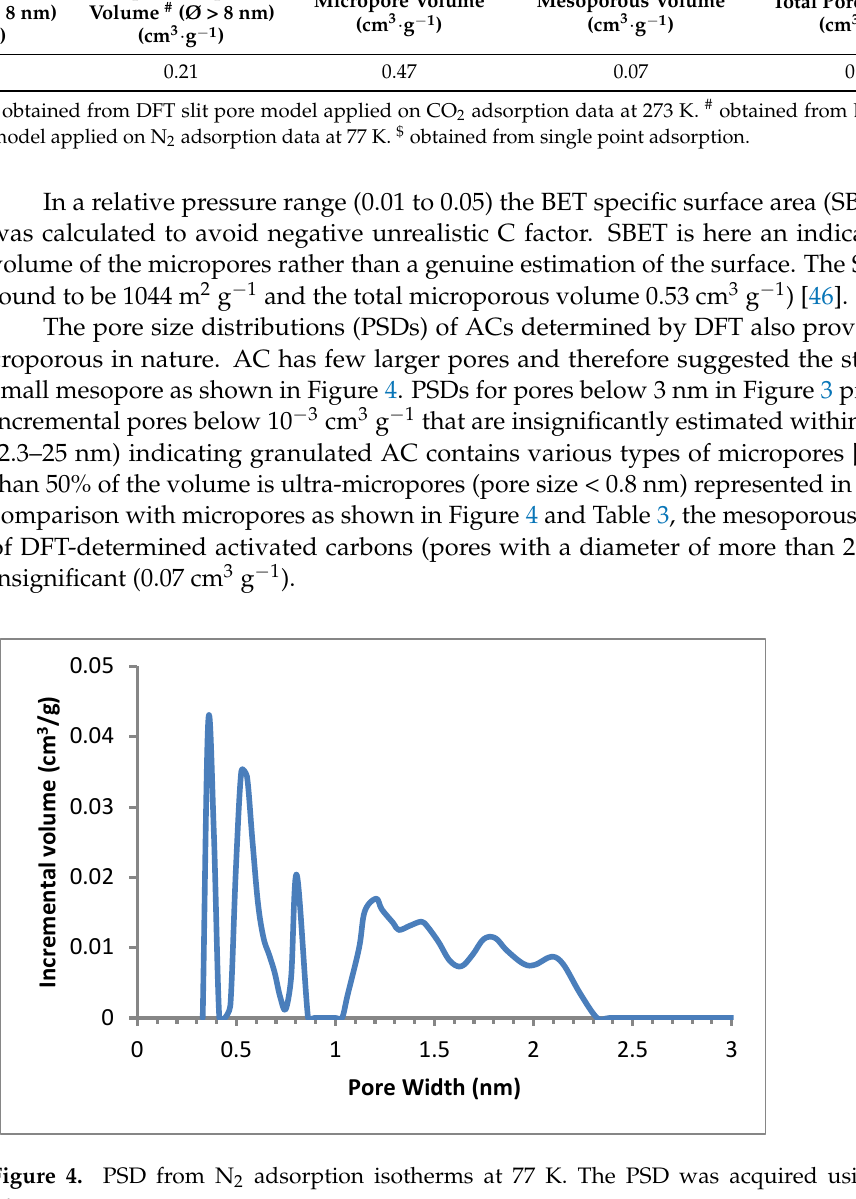
Figure 4. PSD from N 2 adsorption isotherms at 77 K. The PSD was acquired using method of 2D-NLDFT.